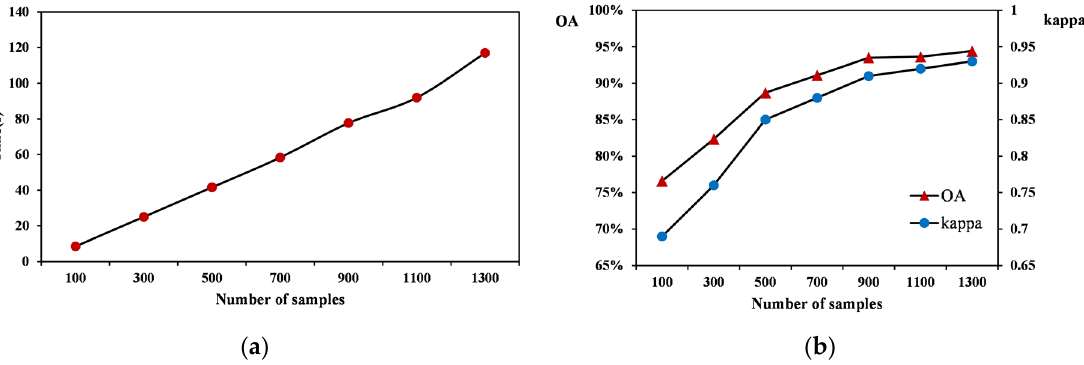
Figure 14. The relationship between number of samples, time-consumption, and classification accuracy. ( a ) Time–Number of samples. ( b ) OA/kappa–Number of samples.